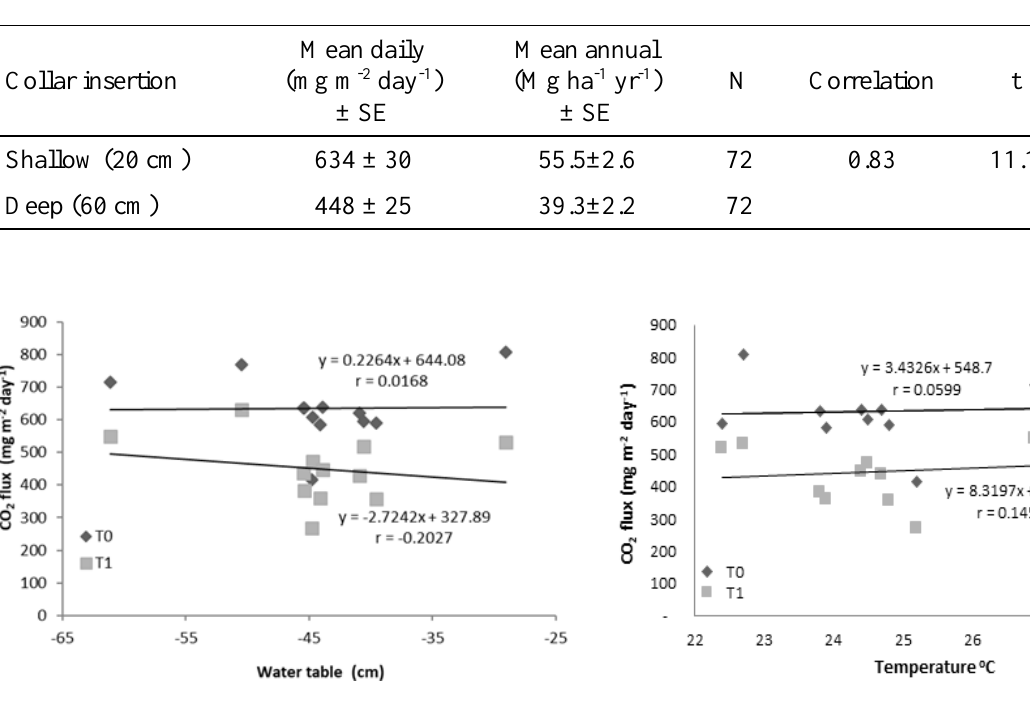
Figure 5. Relationship between soil temperature and carbon dioxide (CO 2 ) for the shallow (T0) and deep (T1) collars (r = Pearson